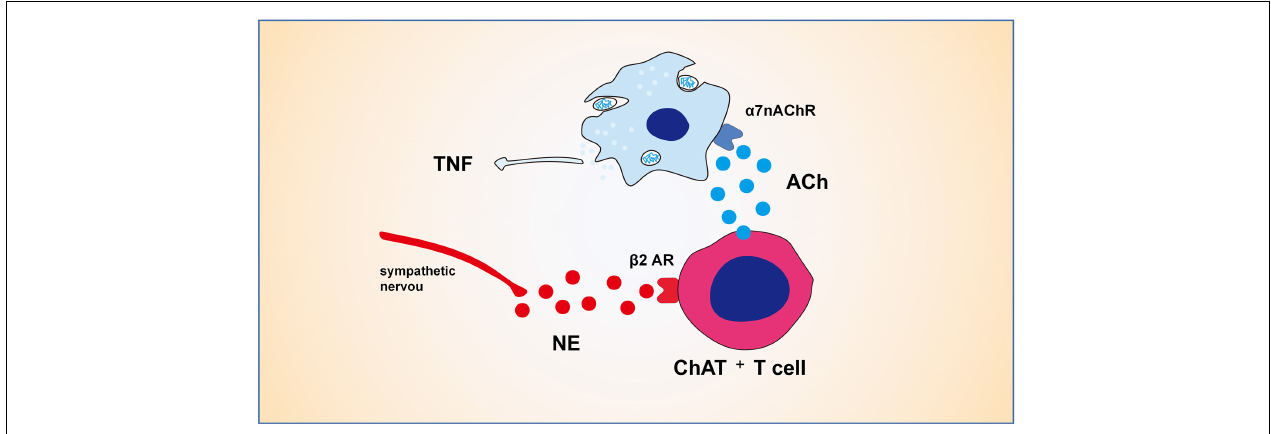
FIGURE 2 | Mechanisms of cholinergic anti-inflammatory pathway. The CAIP depends on norepinephrine produced by splenic sympathetic fibers, which can lead ChAT + T cell to release ACh through β 2 receptor. ACh from ChAT + T cell binds to the α 7-nAChR on the bone marrow-derived non-T cells like macrophages along with inhibiting LPS-mediated cytokine